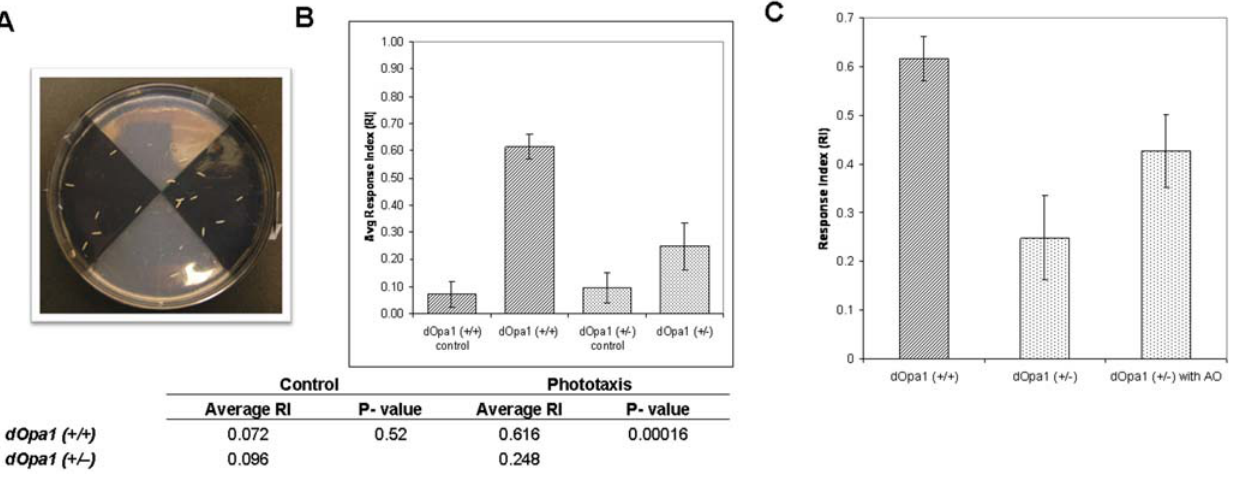
Figure 3. A . Larval phototaxis assay . A plastic petri plate was divided into four quadrants, two dark quadrants diametrically opposite to two clear quadrants. 1% agarose was used for the clear and 1% agarose containing 0.6% charcoal powder was used for the dark quadrants. 50 second instar larvae were placed at the center of the plate and were allowed to migrate for 3 minutes in complete darkness for the control, and in the presence of light by using a light box. The assay was repeated 3 times. Figure 3B. Larval Phototaxis Response Index . 50 second instars were used for each trial (total of 3 trials each). Wildtype dOpa1 + / + exhibited strong negative phototatic response in the presence of light (RI=0.616). Heterozygous mutant dOpa1 + /in3 showed little light response (RI=0.248). Antioxidant treatment made no difference in wildtype dOpa1 + / + (RI=0.667). Mutant dOpa1 + /in3 treated with antioxidant exhibited a significantly stronger negative phototatic response to light (RI=0.427).